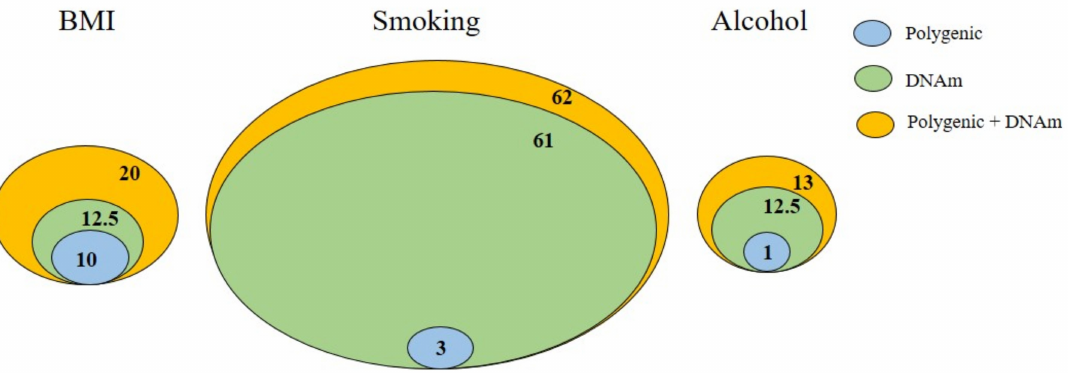
Figure 3. DNAm and polygenic prediction of the health and lifestyle factors. The proportion of phenotypic variance explained (R2) is plotted for three traits: the body mass index (BMI), smoking, and alcohol consumption (alcohol), based on each trait’s polygenic score (blue), DNA methylation- based score (green), and additive genetic + epigenetic score (yellow). Data were taken from [130]. Reprinted/adapted with permission from ref. [19]. 2022, Diana M.